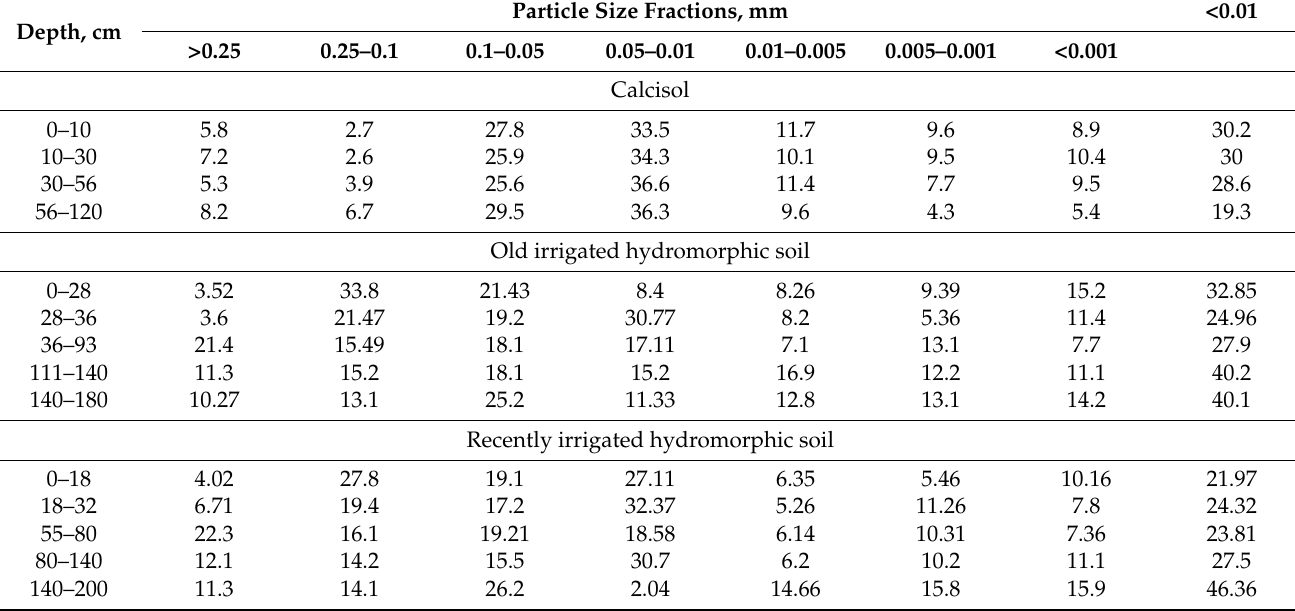
Table 2. Soil particle size distribution in the fine